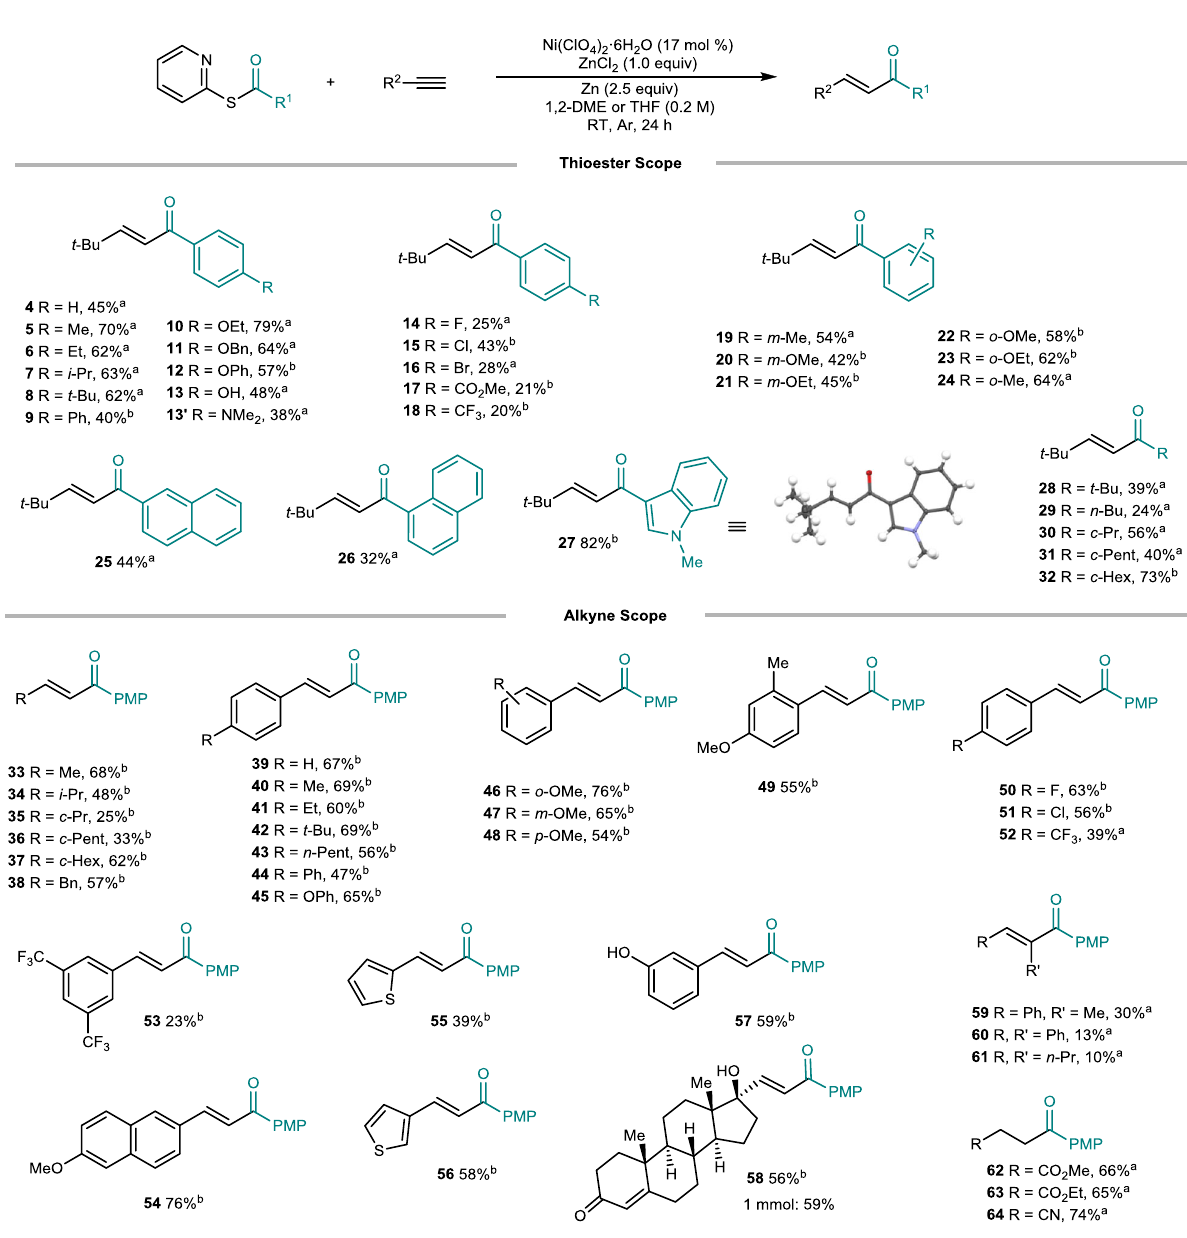
Fig. 2 Scope of the nickel-catalyzed hydroacylation. Reaction conditions: a Thioester (0.20 mmol), alkyne (1.5 equiv), 1,2-DME. Reaction conditions: b Thioester (0.20 mmol), alkyne (1.5 equiv), THF, 2,2 ′ -dipyridyl disul fi de (20 mol%). Isolated